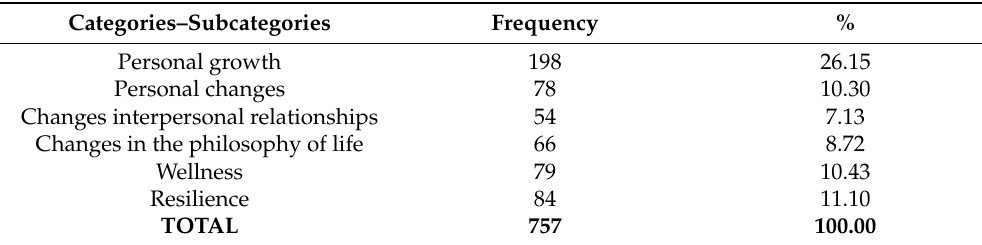
Table 1. List of categories and